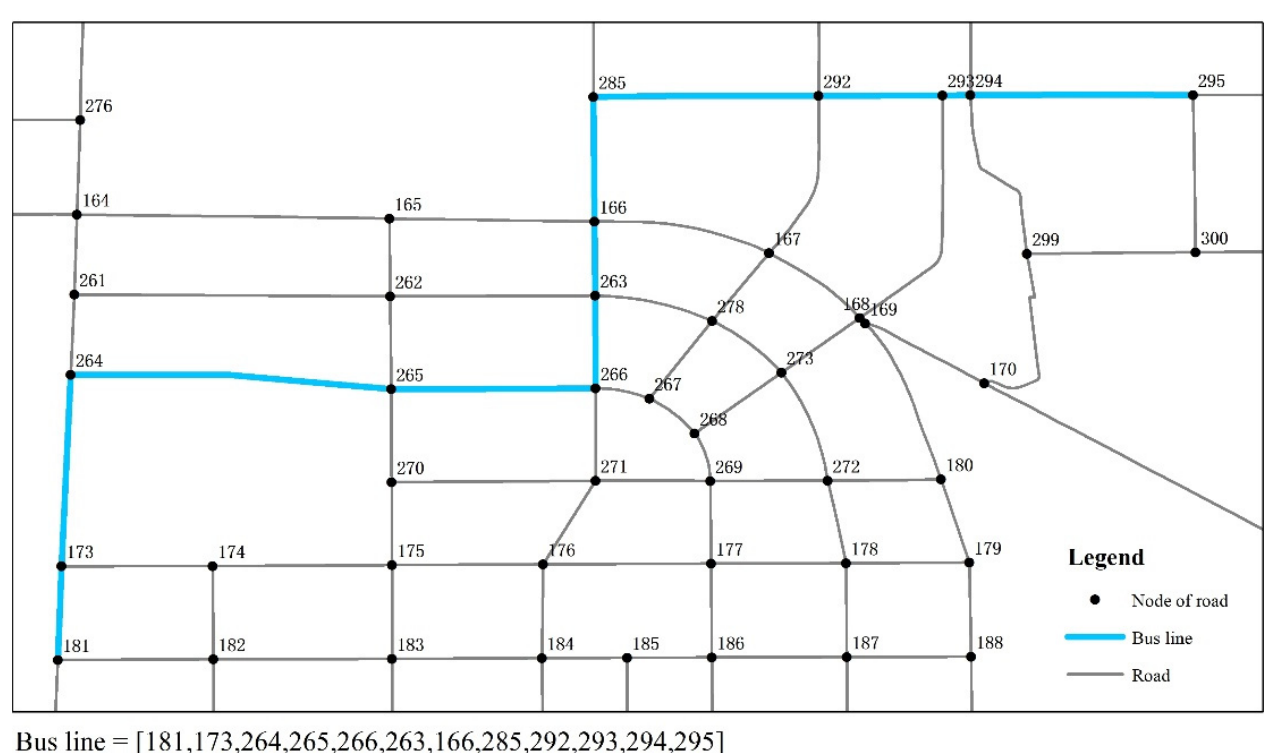
Figure 3. Node expression of roads.